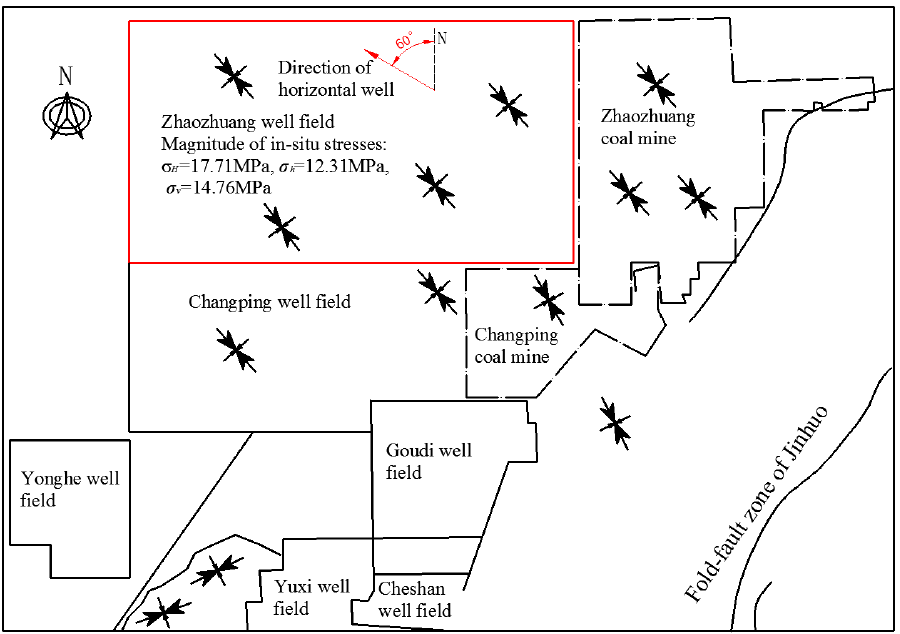
Figure 14. In situ stress distribution map of the Zhaozhuang well field (modified after [24] with permission from Kang et al., 2009).